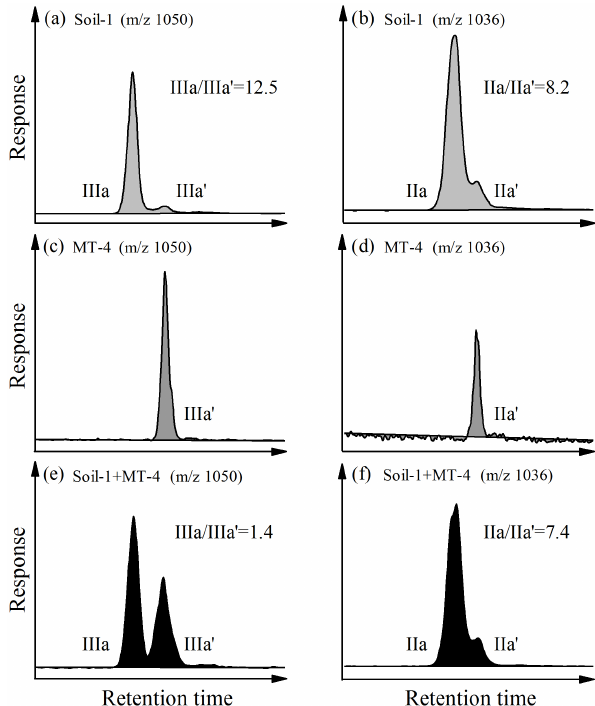
Figure 3. Extracted ion chromatograms (EICs) of m/z 1050 (a, c, e) and m/z 1036 (b, d, f) showing separation of 5-methyl and 6- methyl brGDGTs in soil (a, b) , Mariana Trench sediment (c, d) , and combined soil and sediment (e, f)